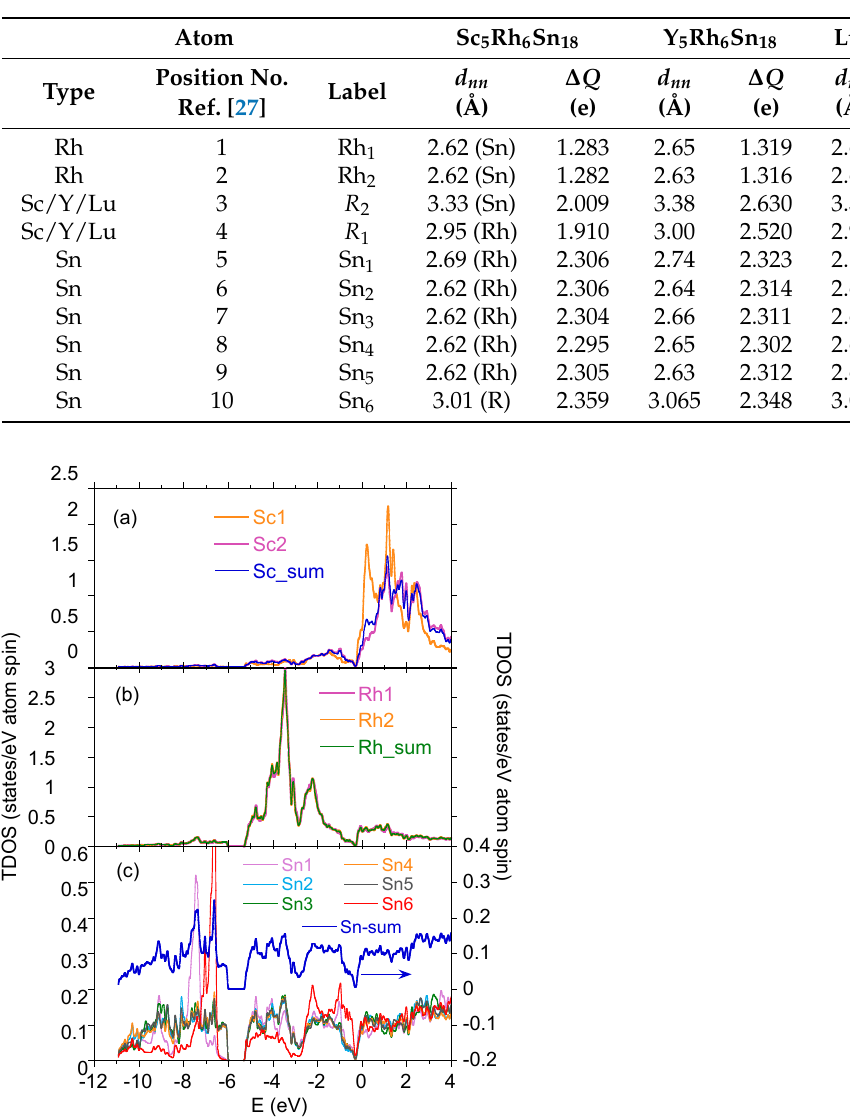
Table 1. Atomic local properties—distance to nearest neighbour d nn and charge leakage from atomic muffin-tin spheres ∆ Q . Position No. enumerates Wyckoff positions, the coordinates of which are given in Table 1 of [27]. Subscripts in atomic labels indicate different Wyckoff positions.